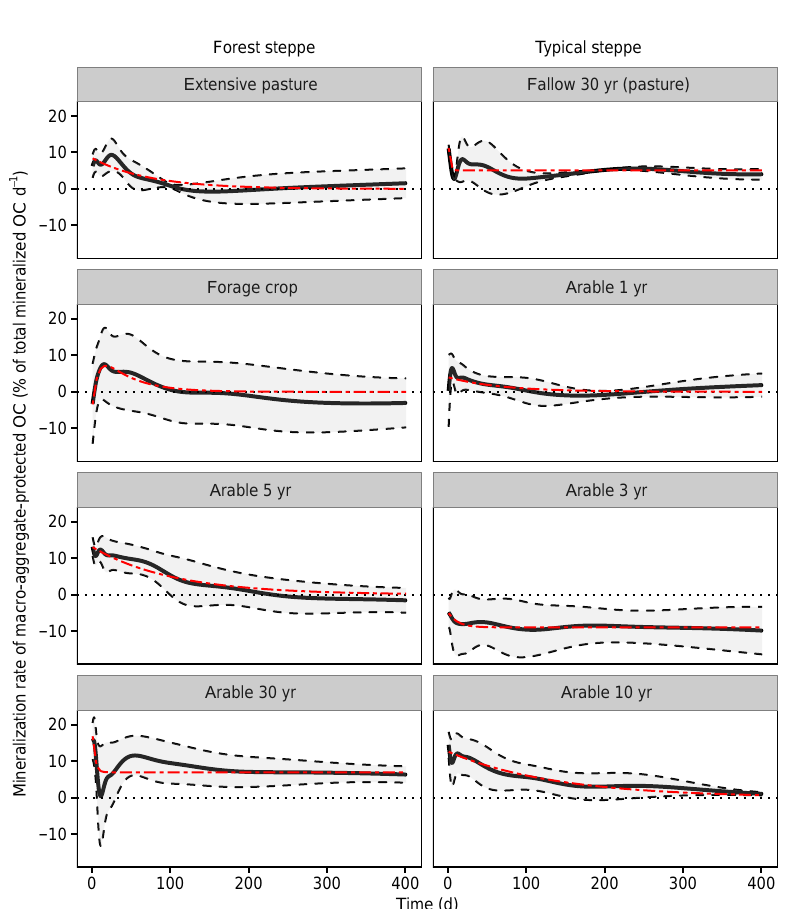
Figure 5. Mineralization rate of macro-aggregate-protected OC (% of total mineralized OCd − 1 ) during 401 days of incubation for eight plots within two steppe types. The black solid line shows the mean mineralization rate per plot and the shaded gray area (confined by the black dashed lines) shows the corresponding standard error. The red dot-dashed line shows the fit of an exponential-decay model (either one- pool model, two-pool model, or asymptotic two-pool model according to the best fit). Since the mineralization rates have been calculated by subtracting the OC mineralization rates of intact macro-aggregates from that of crushed macro-aggregates, negative values occur when the OC mineralization was smaller in crushed than in intact